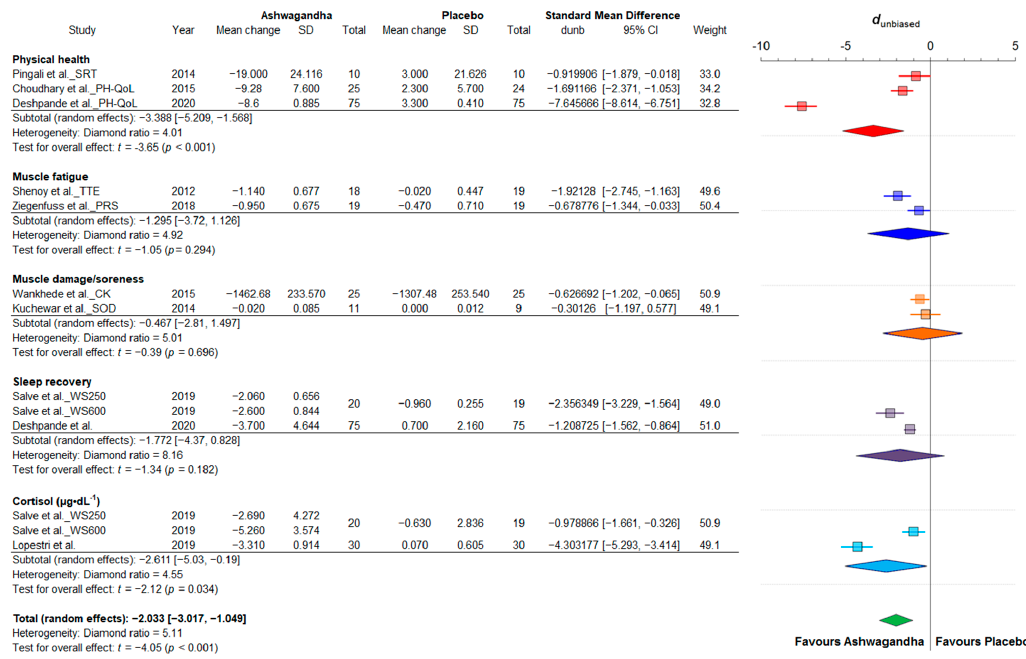
Figure A2. Forest plot depicting the standardized mean differences from a meta-analysis of all studies (including outliers) comparing groups with Ashwagandha or placebo on fatigue/recovery. Colored squares represent the d unb for individual trials, while colored and green polygons depict the meta-analytic d unb for the indicated subgroups and for the overall (total) results, respectively. Horizontal lines represent the 95% confidence intervals for the data. SRT: simple reaction time; PH-QoL: physical health component of the quality of life test; TTE: time to exhaustion; PRS: perceived recovery scale; CK: creatine kinase; SOD: superoxide dismutase; SE: sleep efficiency; QoS: quality of sleep; WS250: Withania somnifera 250 mg; WS600: Withania somnifera 600 mg.